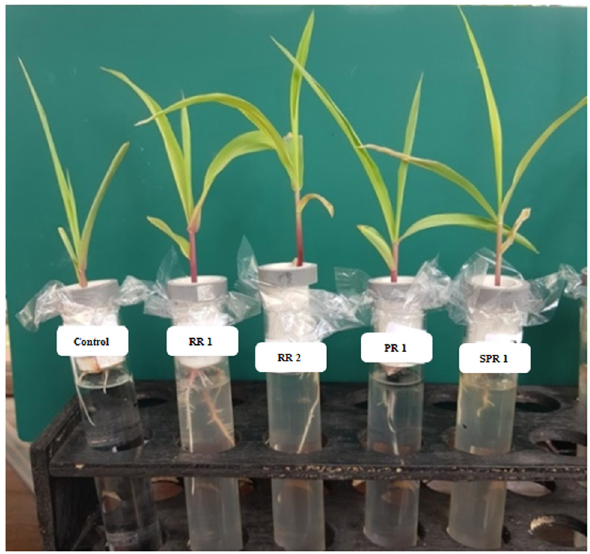
Figure 1: The visual growth performance of maize seedling due to the inoculation with PSB